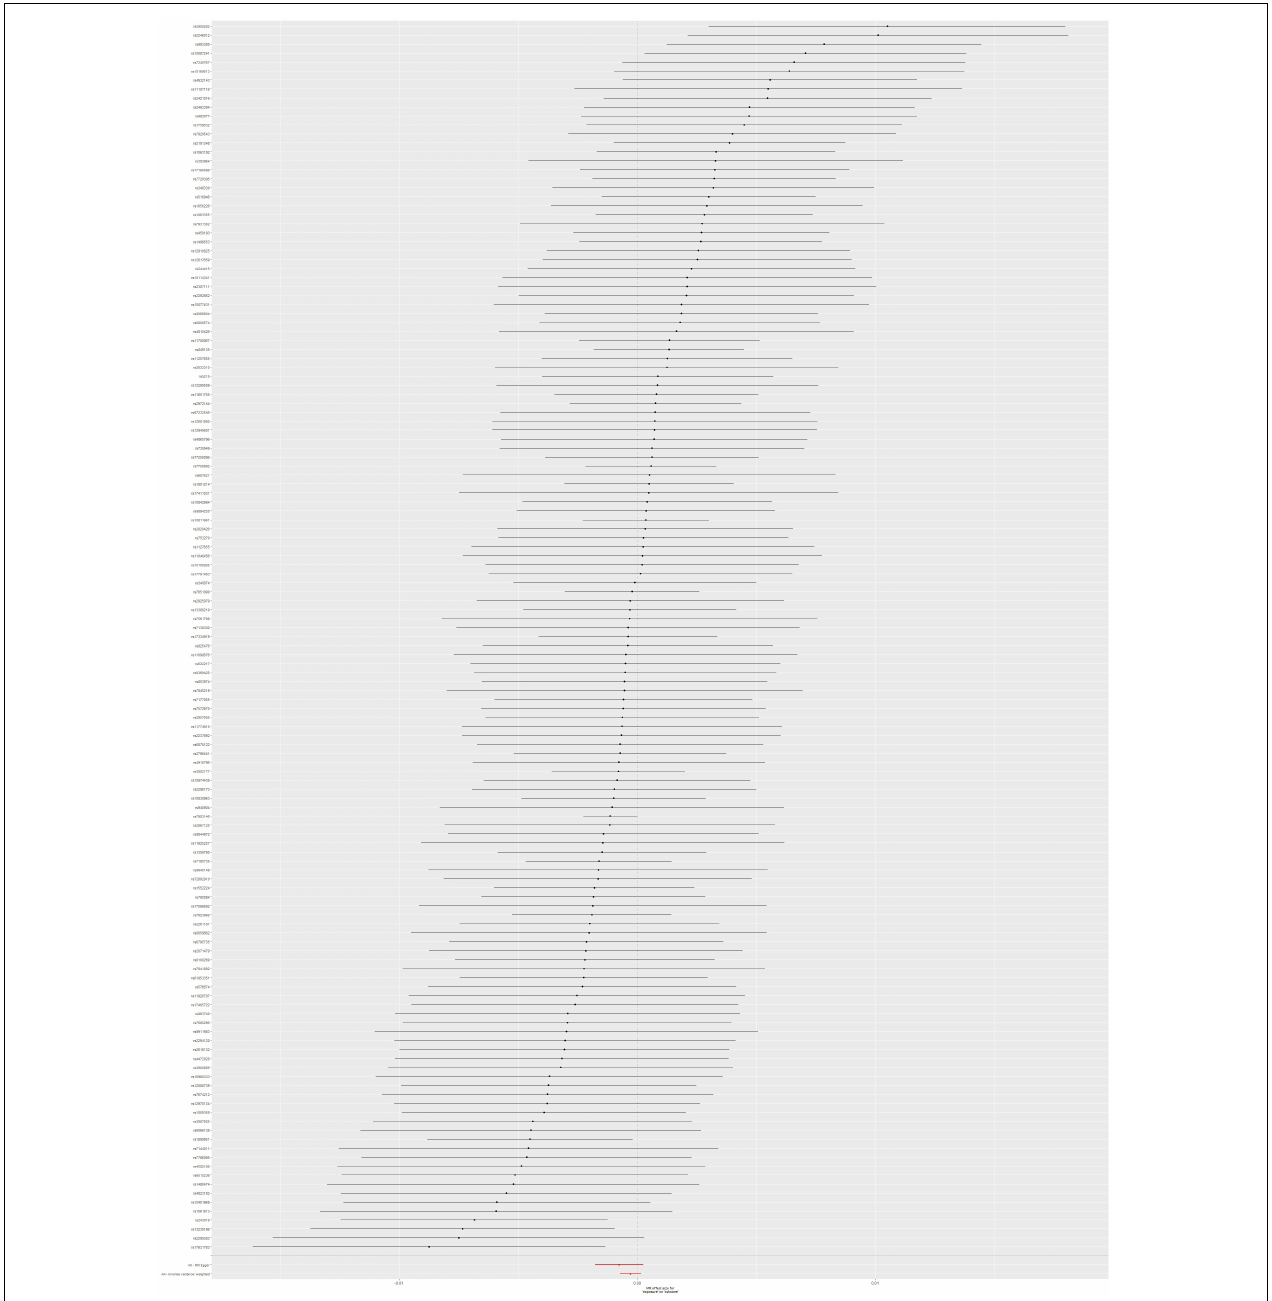
FIGURE 4 | Forest plot: the associations between T2DM-related SNPs and UTI risk. T2DM, type 2 diabetes mellitus; UTI, urinary tract infection; SNPs, single-nucleotide polymorphisms; OR, odds ratio; CIs, confidence